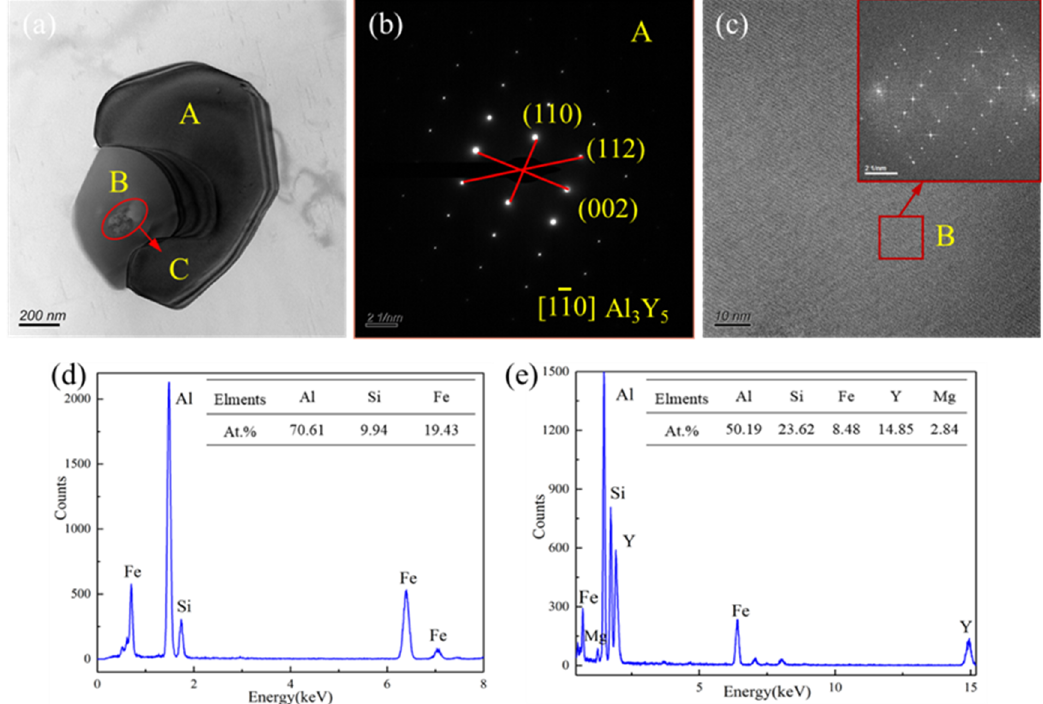
Figure 10. TEM bright field phase of the intragranular particles of the typical sample under the deformation condition of 480 °C/0.01 s −1 and the electron diffraction spots of the selected area, high-resolution auxiliary phase and energy spectrum of the corresponding area: ( a ) TEM bright field phase of particles; ( b ) selected area electron diffraction spots in area A; ( c , d ) high-resolution auxiliary phase and energy spectrum of area B; ( e ) corresponding energy spectrum of area C.